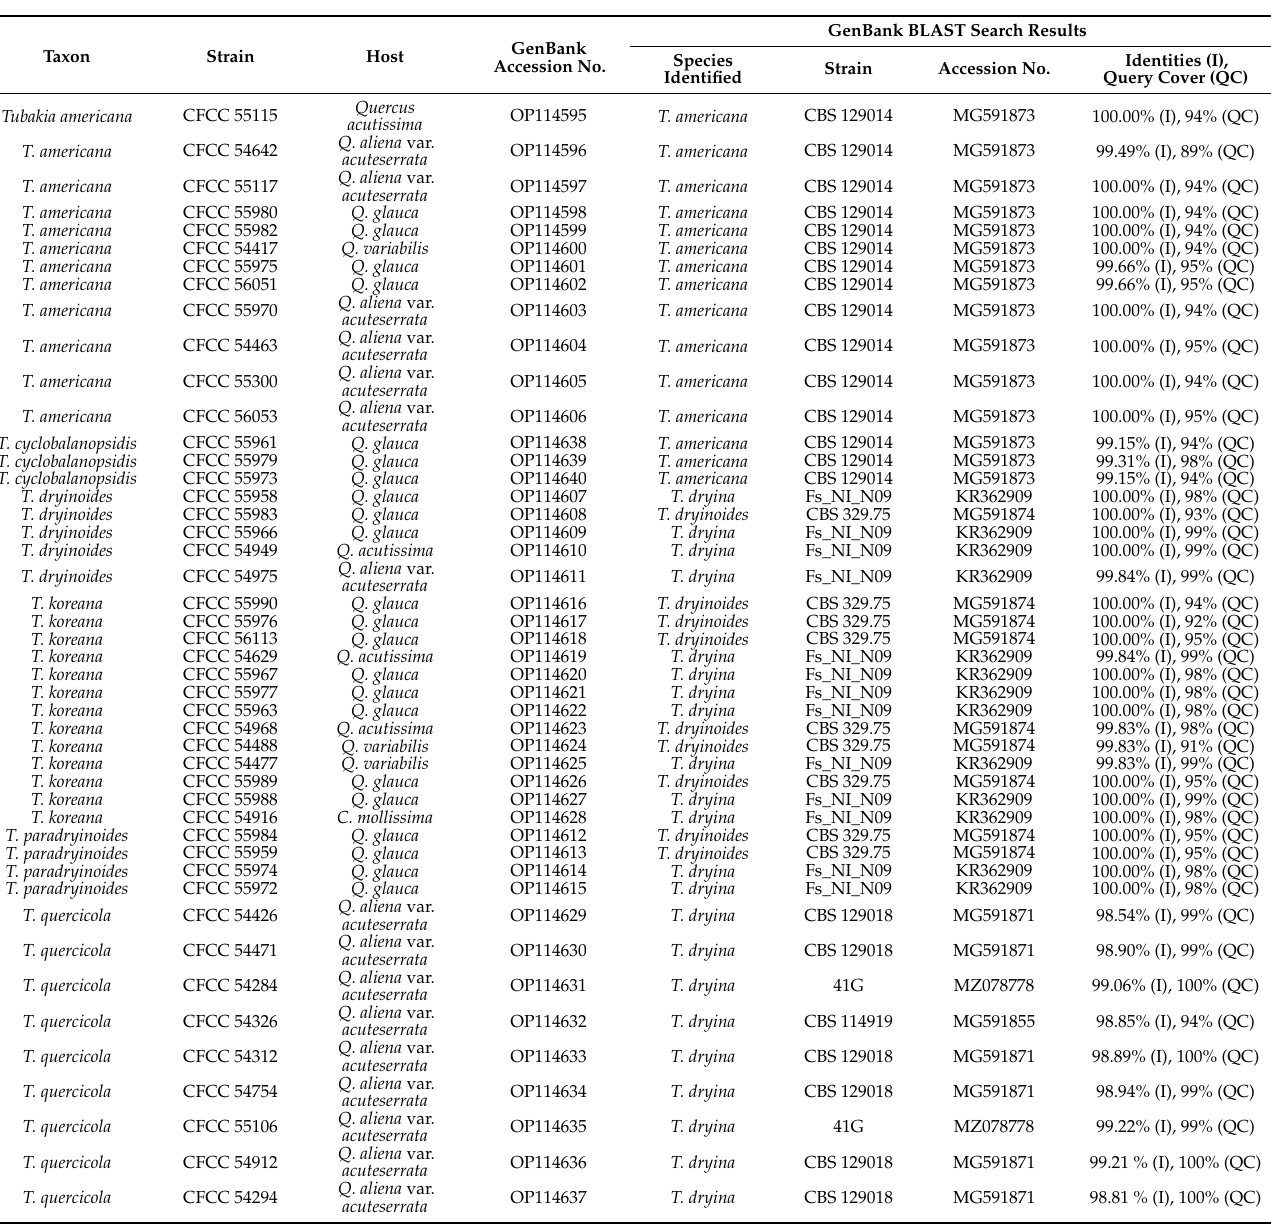
Table A1. The results of BLAST search using ITS sequence